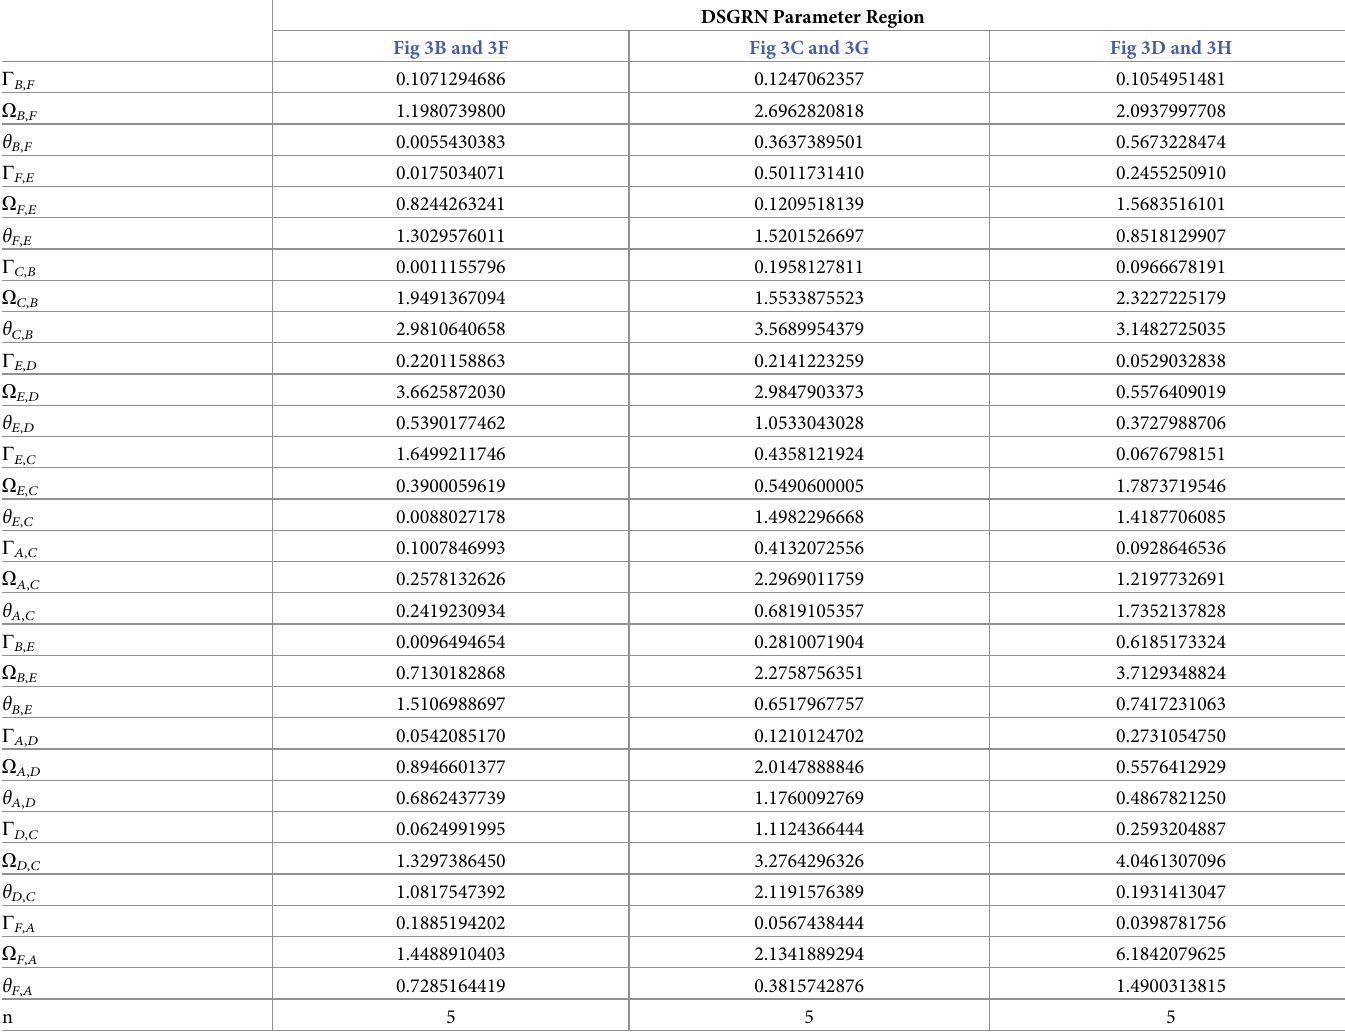
Table 2. Synthetic network ODE